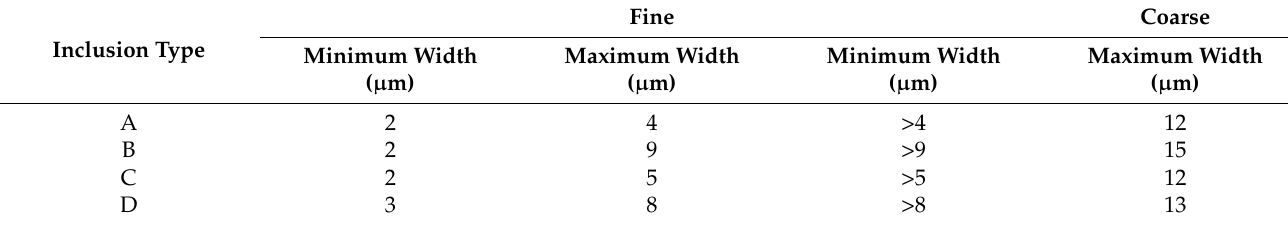
Table 8. Criteria for determining the thickness of inclusions.